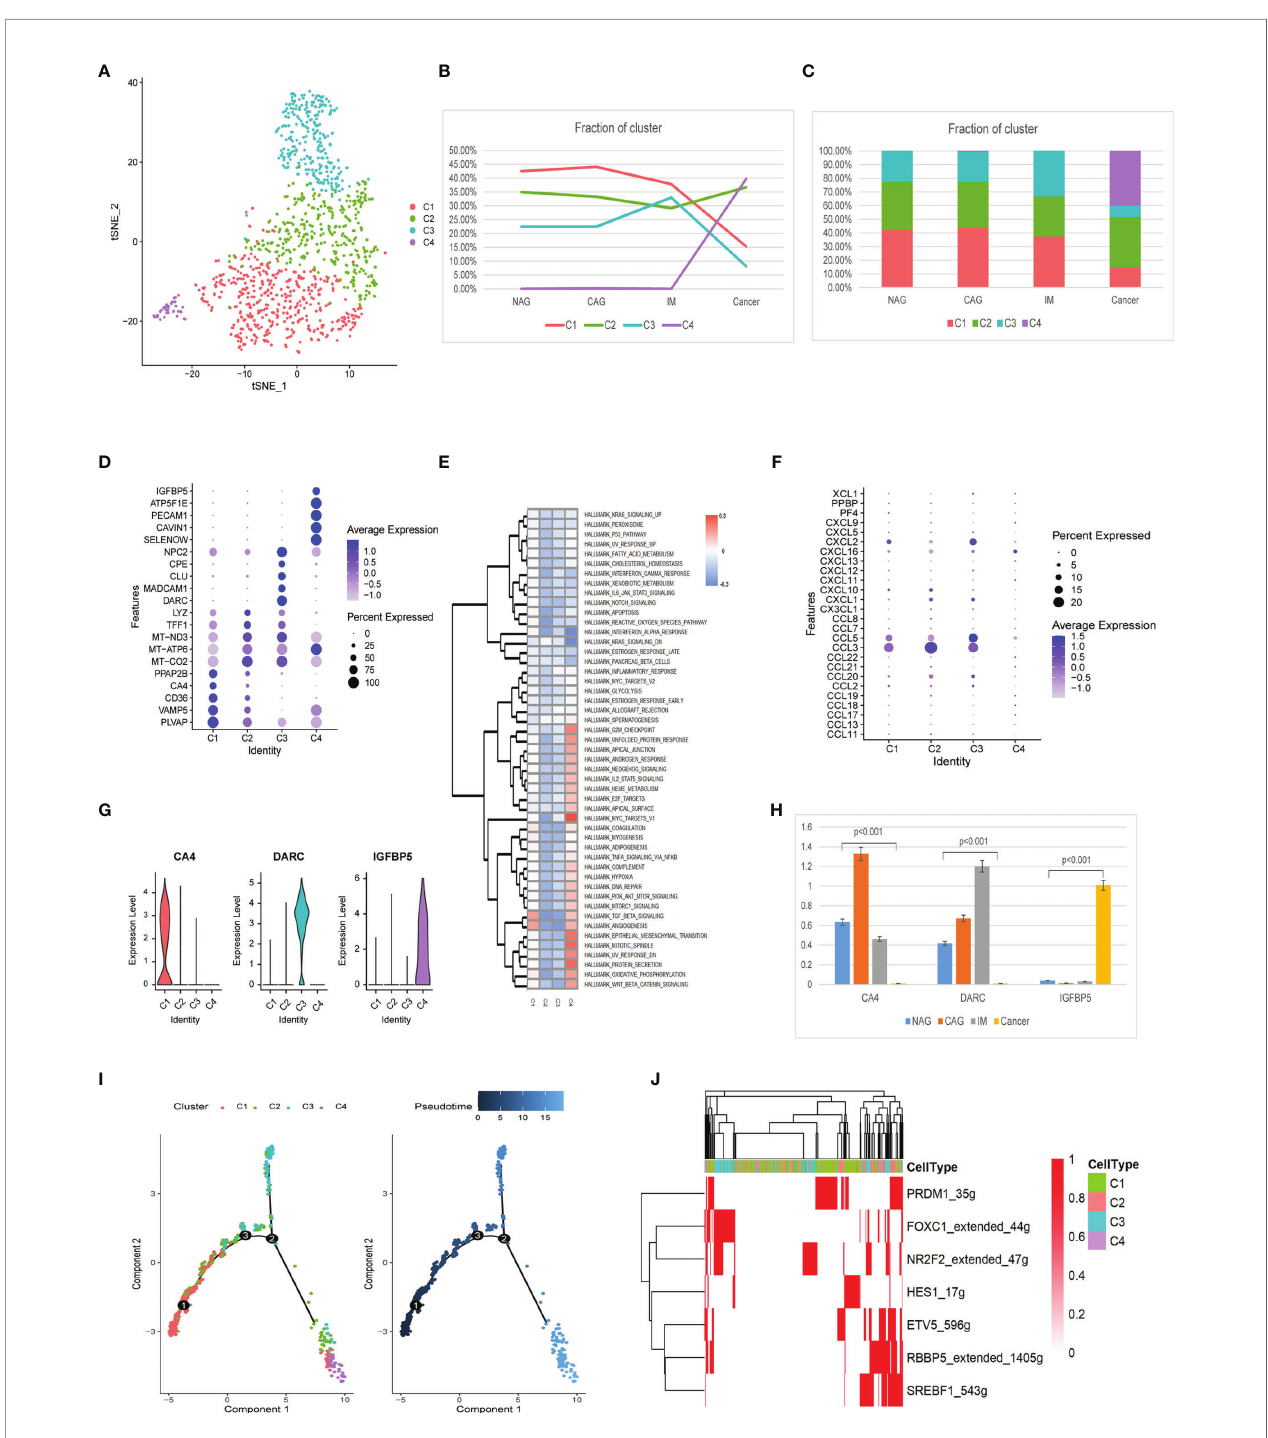
FIGURE 7 | Identi fi cation of endothelial cell clusters and expression features at different stages. (A) tSNE plot of the four endothelial cell subclusters. (B) Line chart displaying changing trend of the proportion of the four cell types across the four stages. (C) Stacked histogram showing endothelium composition across the four stages. (D) Bubble plot of the top fi ve markers of each cell cluster; dot sizes represent abundance while colors represent expression levels. (E) Heatmap showing activity differences in 50 hallmark pathways scored by GSVA. T values are calculated using a linear model. (F) Bubble plot showing scale normalized expression of representative genes involved in chemokine processes. (G) Violin plots of marker genes for the fi ve subclusters. (H) Histograms of scale normalized expression levels of three marker genes at each stage. (I) Endothelial cell differentiation trajectory, with each color coded for pseudotime (right) and clusters (left). (J) AUC scores of TF expression regulation using SCENIC. Results converted to binary data were visualized as heatmap plots constructed using the pheatmap function of